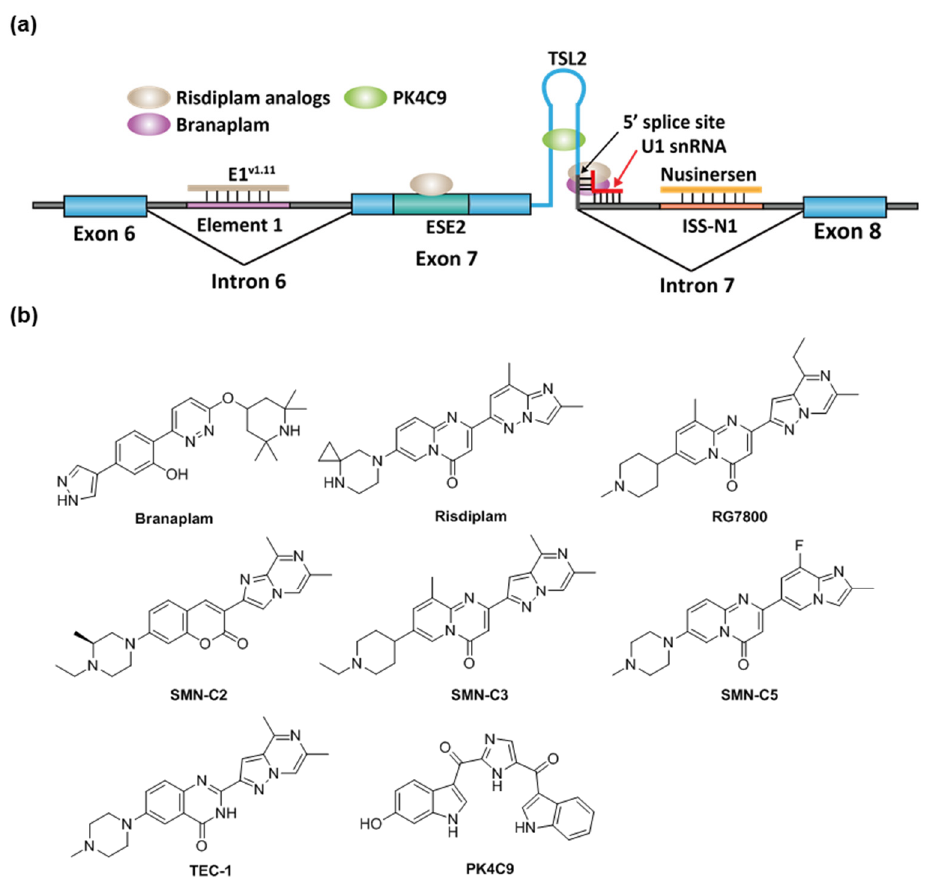
Figure 5. ( a ) Binding sites of the existing drugs for the treatment of SMA. Risdiplam has two bind- ing sites on the SMN2 pre-mRNA exon7. ( b ) The structures of known RNA-targeting small-mole- cule splicing modifiers for SMN2 exon